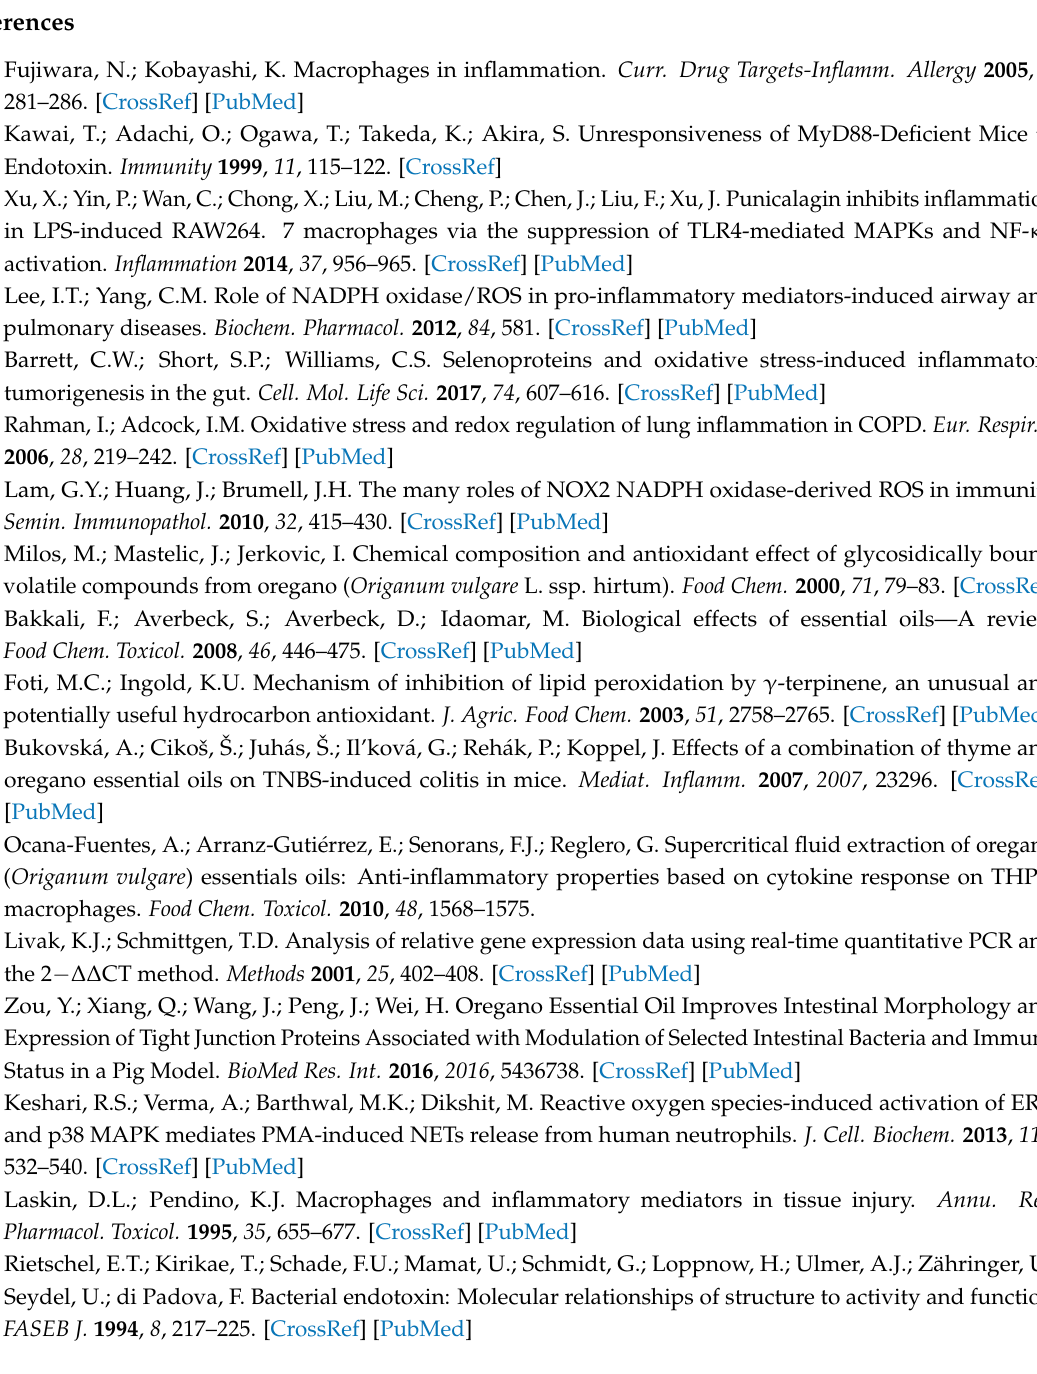
Supplementary Materials: Supplementary materials are available online, Figure S1: Typical chromatogram of oregano essential oil components, Figure S2: Oregano essential oil and LPS induced cytotoxicity in RAW264.7 cells, Table S1: Chemical composition of oregano essential oil